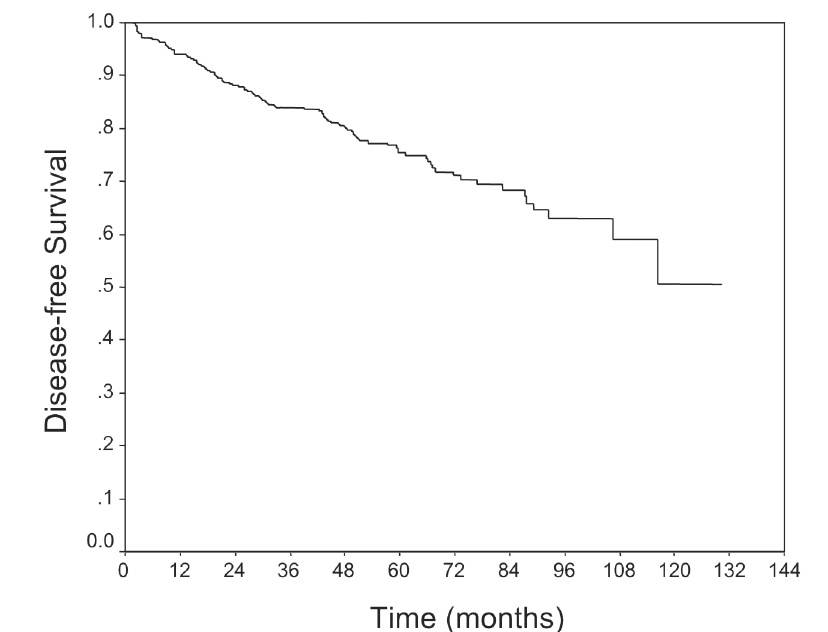
Figure 1 – Probability curve of disease-free survival.